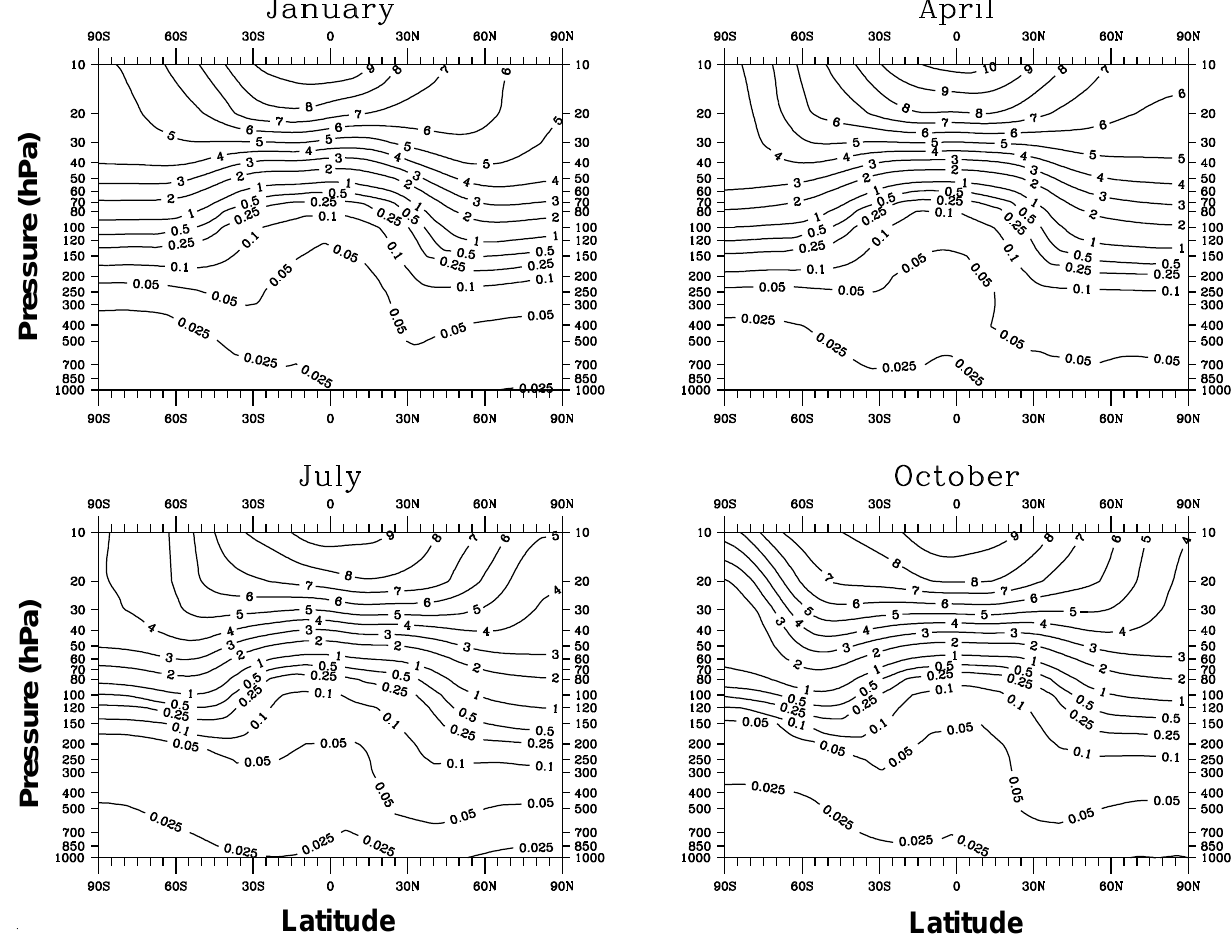
Fig. 11. Climatological monthly averages of the zonal mean ozone mixing ratios (ppmv) in January, April, July, and October, as simulated by